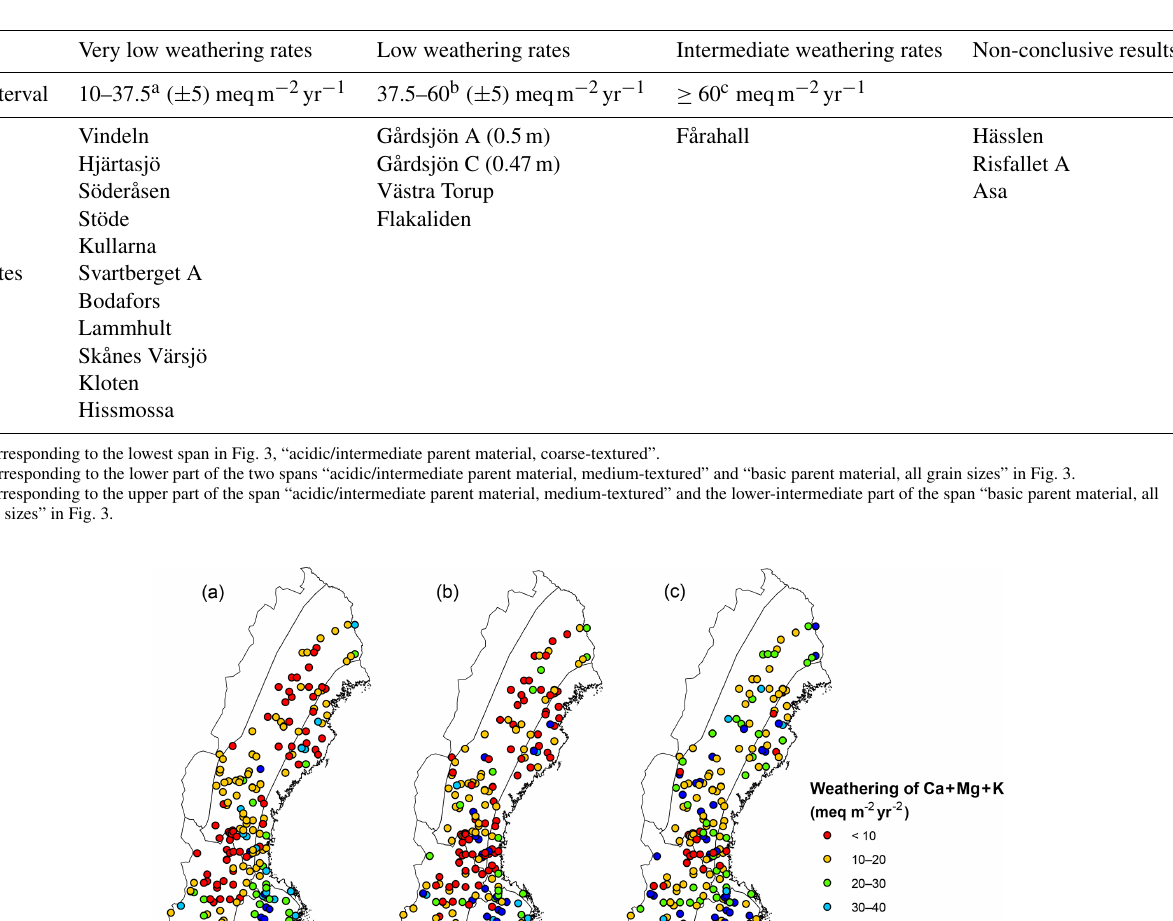
Table 4. Classification of the sites with soil depth of approximately 0.5m, in four classes, based on intervals used in the critical load work of CCE (Coordination Centre for Effects) within the UNECE Convention on Long-range Transboundary Air Pollution (LRTAP convention) (de Vries, 1994; Umweltsbundesamt, 1996): very low, low, and intermediate weathering rates and a group with non-conclusive results, i.e. that did not fit into any of the other groups. Sites were placed in one of the three weathering groups if the median fell within the main interval given and if the maximum and minimum values fell within the extended interval ( ± 5). A and C refer to different profiles, with different soil depths.